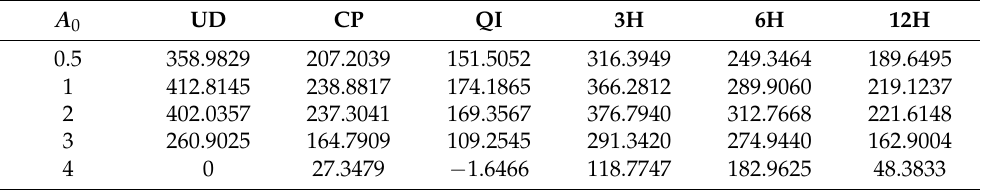
Table 4. First critical buckling loads ( N ) of imperfect C–C composite beams for different layups